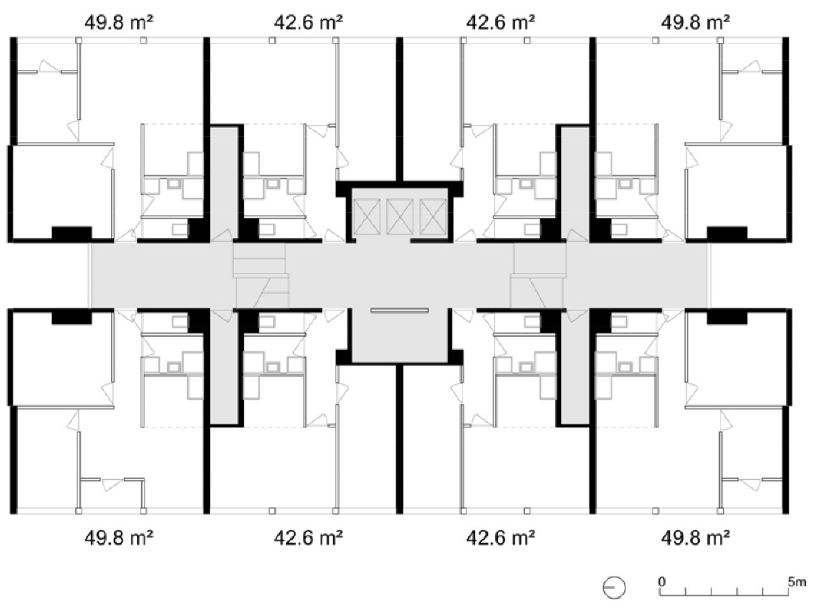
Figure 8. Plan of the Tour Bois le Prêtre in Paris before the transformation with information about the useable area of each apartment. Drawing by the author, based on [21].